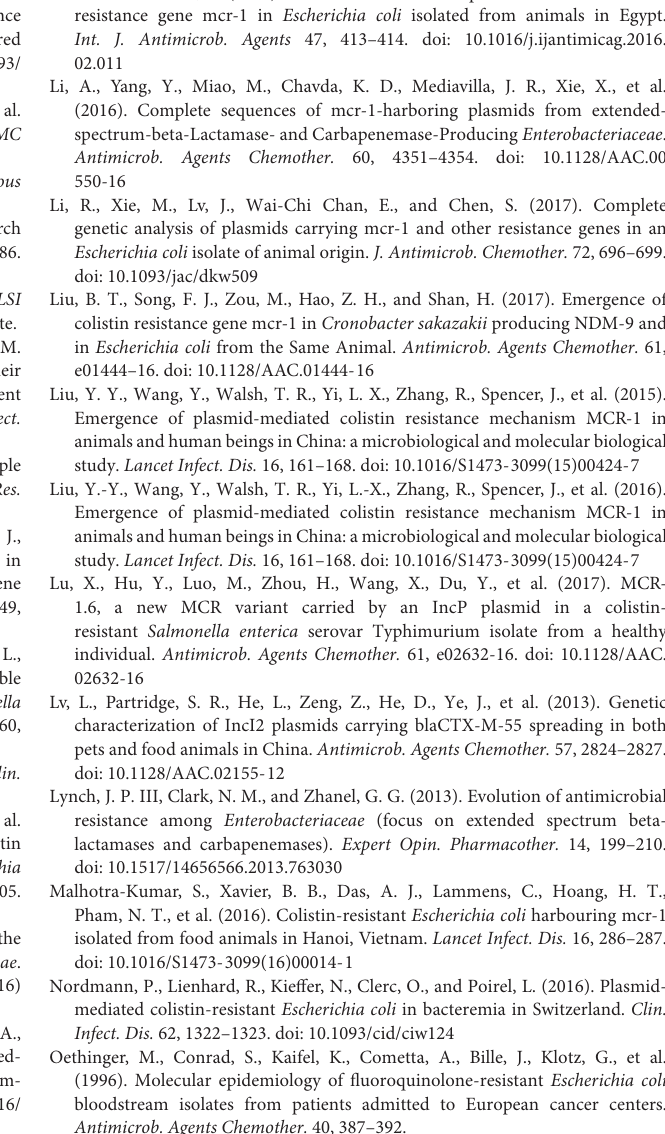
FIGURE S2 | Nucleotide and protein sequence alignments of the mcr-1 gene with its different variants. Only the alignment blocks carrying mutations found in mcr-1.9 are shown. The mutations in the base and amino acid sequences are denoted by the use of a different color. In mcr-1.9 , G was mutated to A in nucleotide position 1036, leading to the replacement of an Aspartic acid residue with an asparagine residue at amino acid position 346. TABLE S1 | List of resistance and virulence factors/genes found in the mcr-1.9 -harboring ETEC identified in this